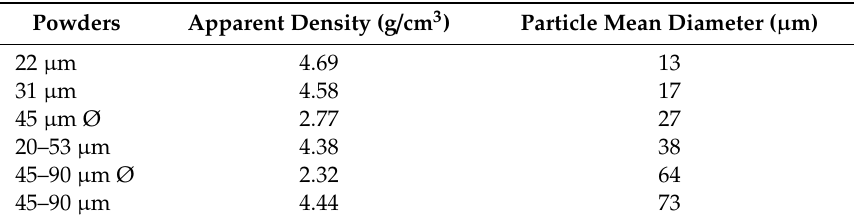
Table 6. Powder density and particle mean diameter [56].